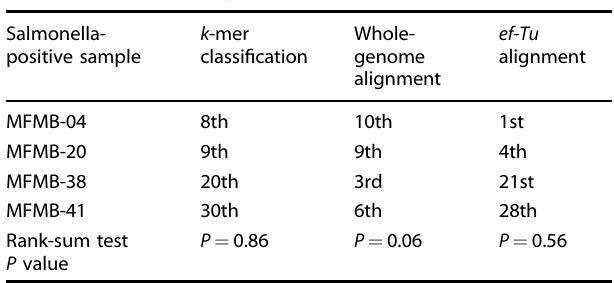
Table 2. Salmonella